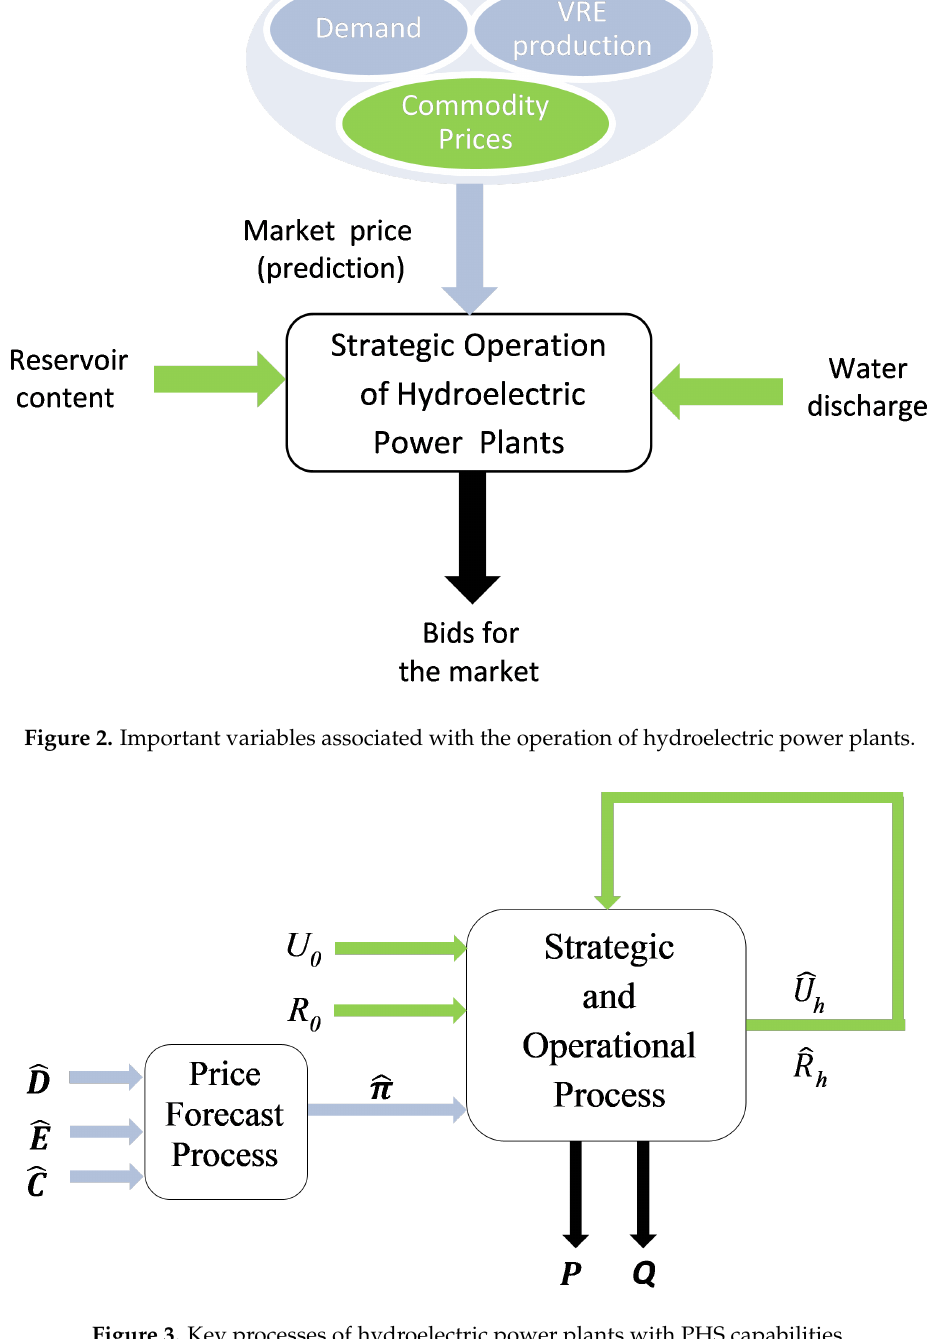
Figure 3. Key processes of hydroelectric power plants with PHS